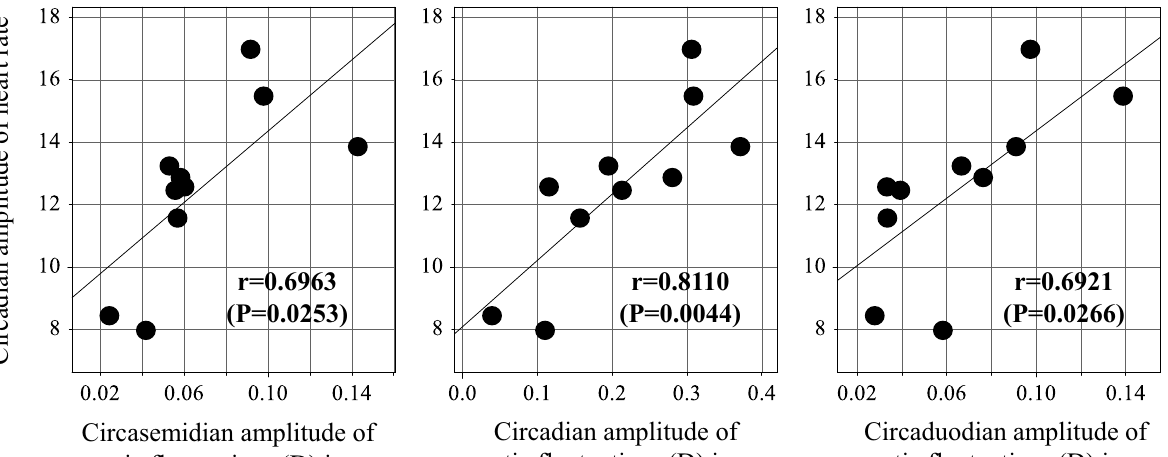
Figure 4. Representative example of correlation between the circadian amplitude of HR and the amplitude of the 12-, 24- and 48-h components of the geomagnetic declination (D) of the geomagnetic field. Effect of magnetic fluctuations on the circadian amplitude of human HR is suggested by its strong correlation with the 12-h (circasemidian; r = 0.6963, P = 0.0253, left panel), circadian (r = 0.8110, P = 0.0044, middle panel), and 48-h (circaduodian; r = 0.6921, P = 0.0266, right panel) amplitudes of D, the declination of the geomagnetic field.